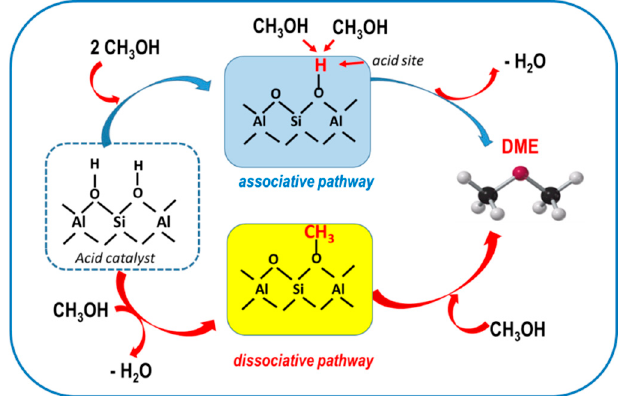
Figure 6. Scheme showing the associative and dissociative routes of the methanol dehydration on acid sites